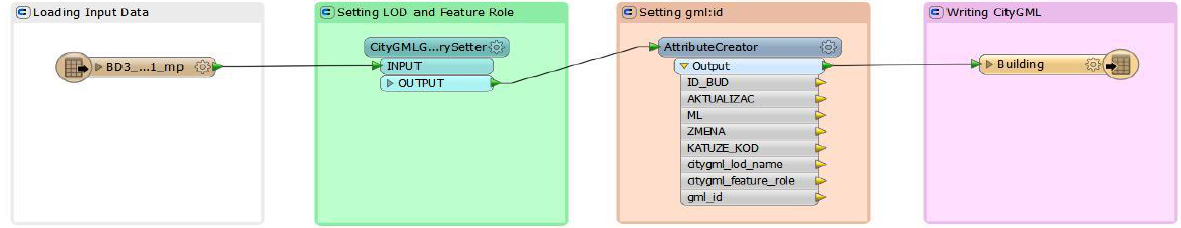
Figure 9 : The Trasformation Scheme for Buildings. (Source: Janecka,